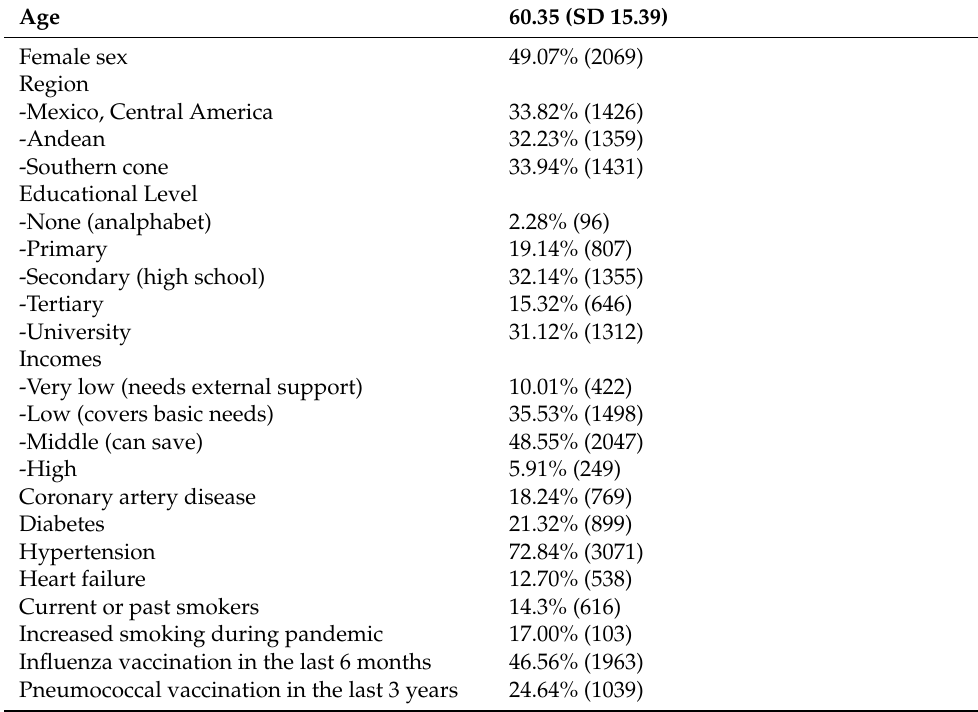
Table 1. Clinical characteristics of the